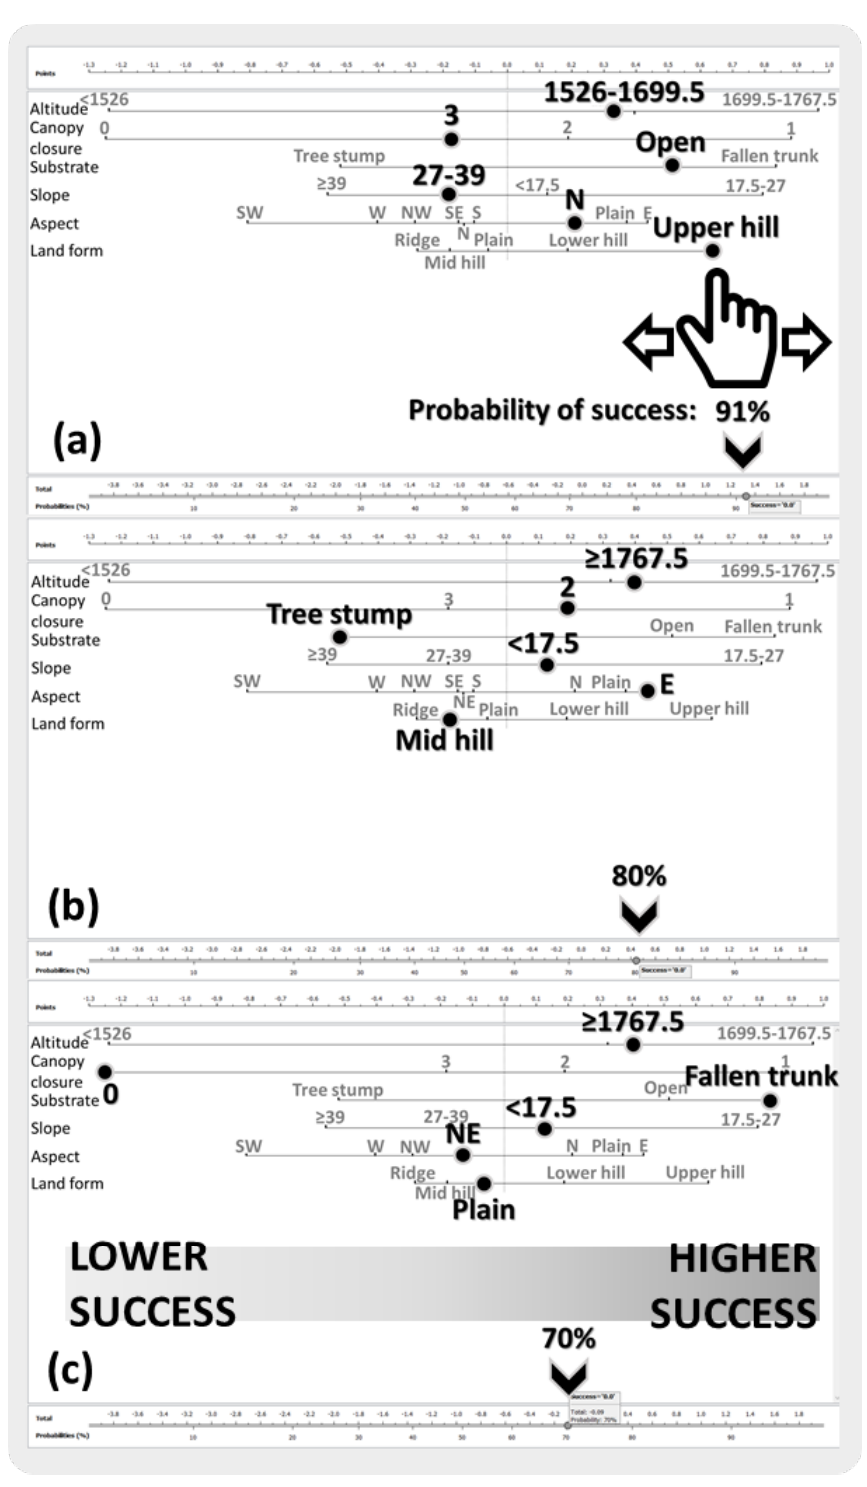
Figure 5. Three examples for nomogram output of naïve Bayes analysis for nest transplantation success prediction, predicting the success rate as 91% ( a ), 80% ( b ), and 70% ( c ). Parameters (altitude, canopy closure, substrate, slope, aspect, and landform) were sorted by the analysis, according to their importance in success prediction (“altitude” is the most and “land form” the least important parameter). Classes of each parameter were sorted by the analysis, according to their impact on success (from left: lower impact to right: higher